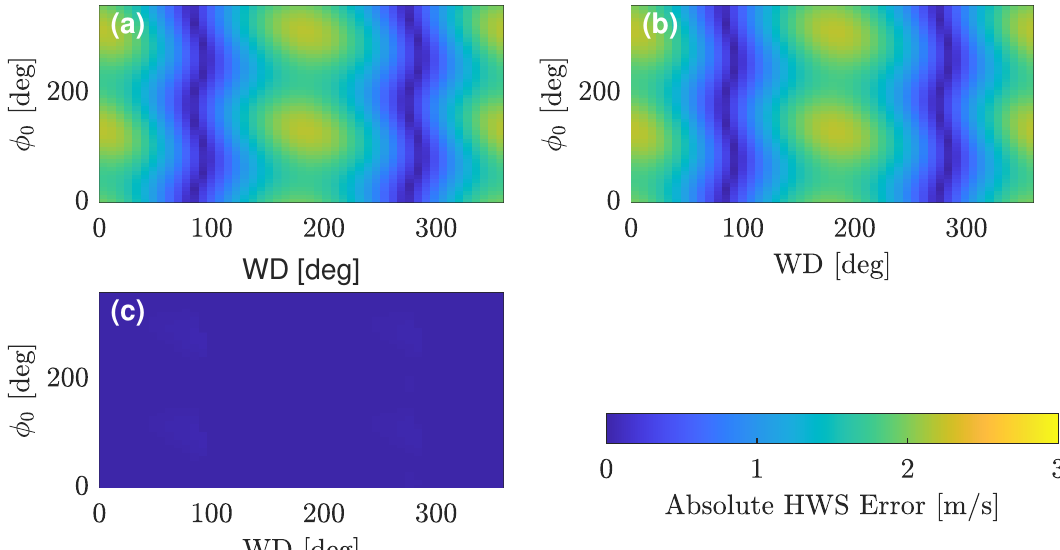
Figure 6. Validation of the analytical-error formulation in the translational-only scenario #2: HWS error (parameters: A surge = 10 deg). ( a ) The analytically estimated HWS error as a function of the wind direction (WD) and the initial scan phase ( φ 0 ). ( b ) The simulator-estimated HWS error. ( c ) The difference of ( a ) minus ( b ) (in absolute